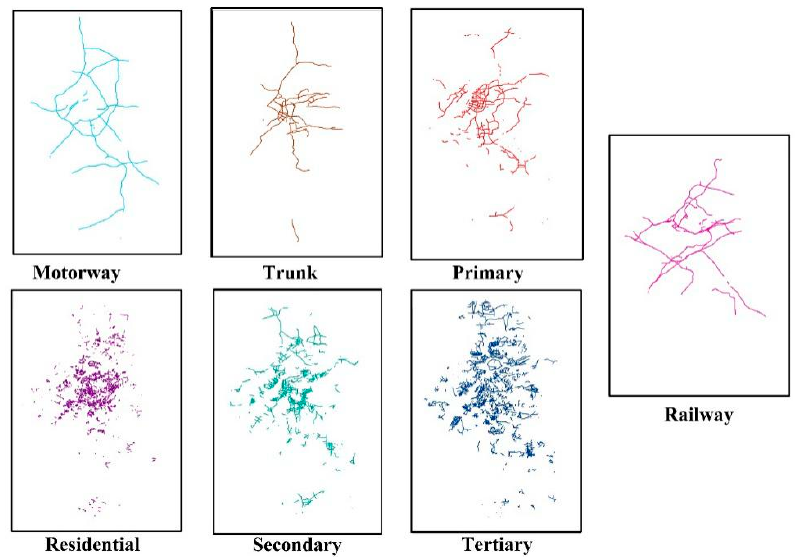
Figure 3. Distribution of different types of roads.